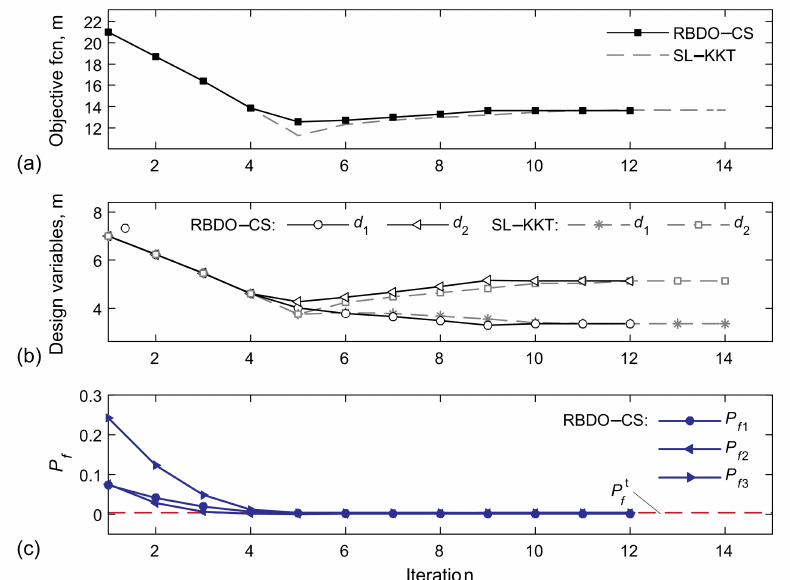
Figure 6. Convergence histories of the proposed RBDO − CS and SL − KKT methods: ( a ) optimal objective function; ( b ) design variables; and ( c ) failure